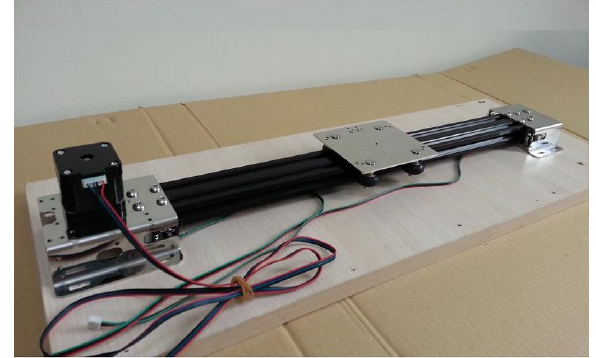
Figure 19. Ball-type linear slide.